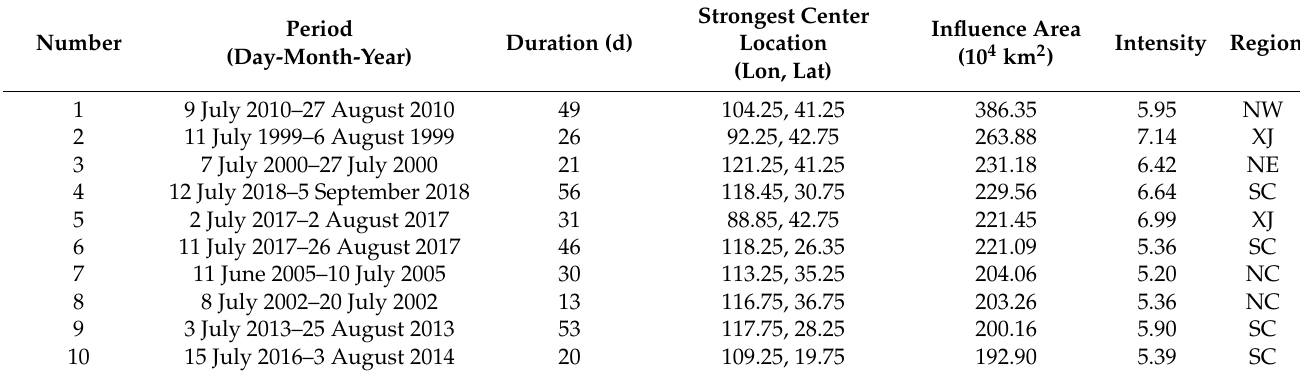
Table 5. List of top ten heatwave events ranked by influence area in the 1979–2018 period in China.